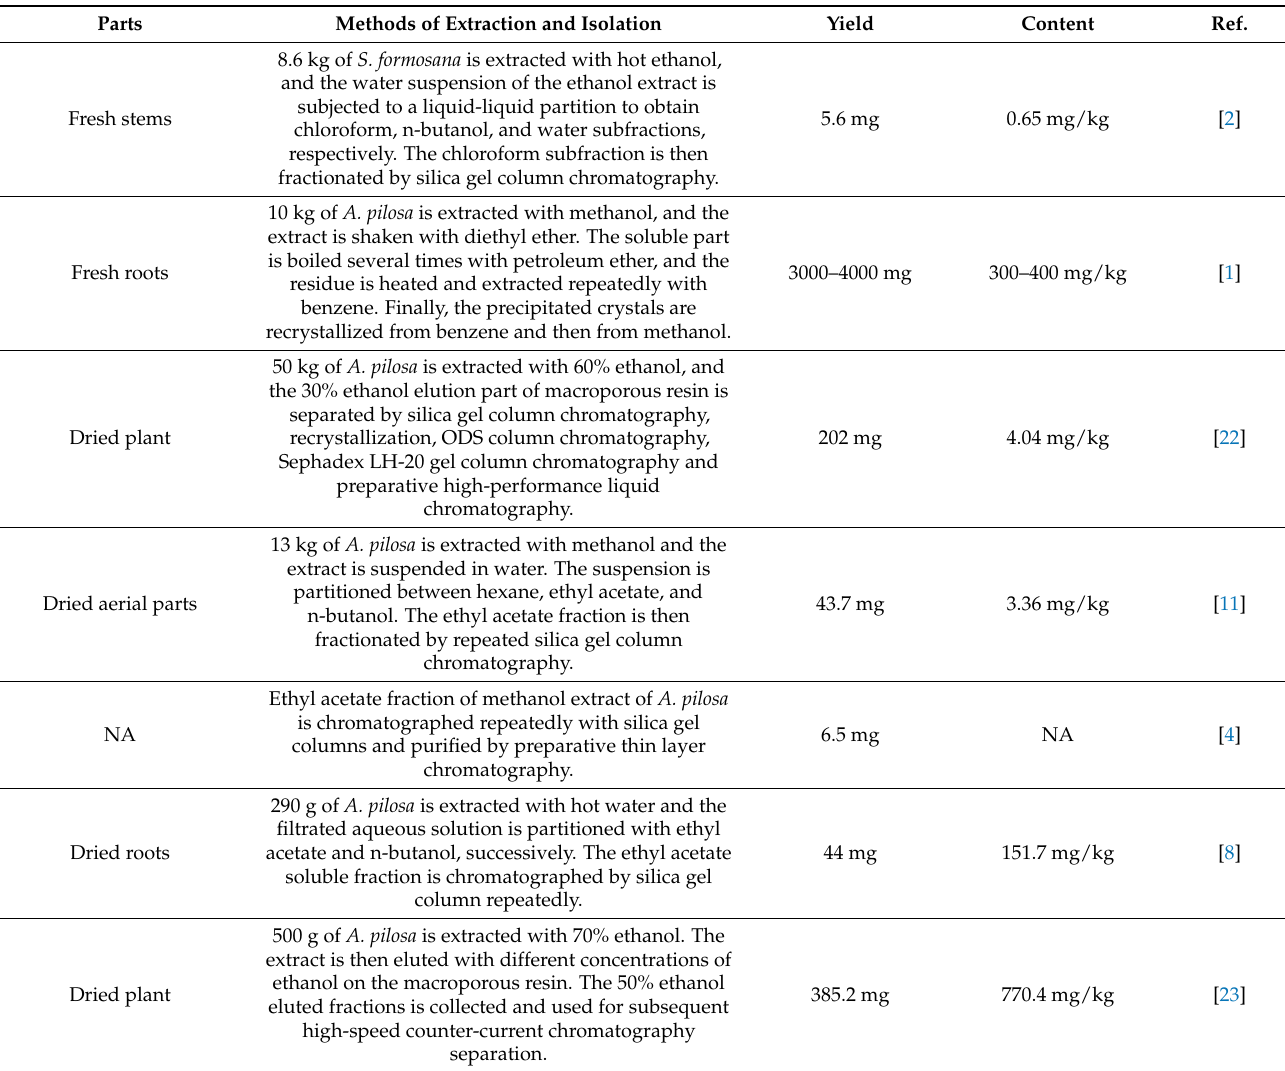
Table 1. Extraction and separation methods of